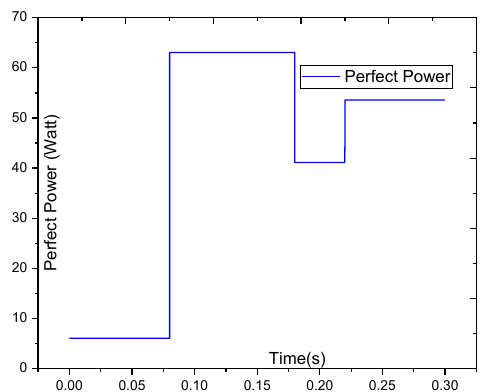
Figure 4: Ideal power of the system used in Matlab / Simulink